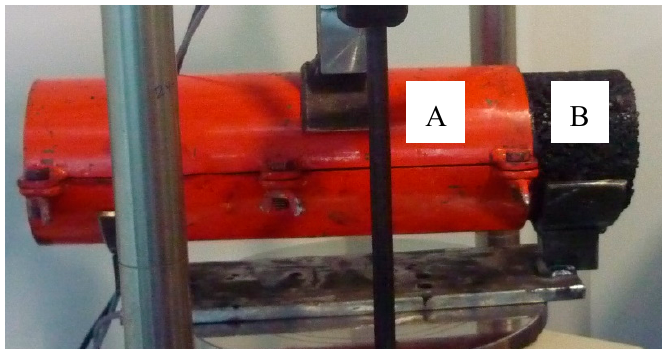
Figure 3. Schematic of forces and tensile stresses on the asphalt test samples: ( A ) specimen part into the casing and ( B ) upper specimen layer under pure shear stress.